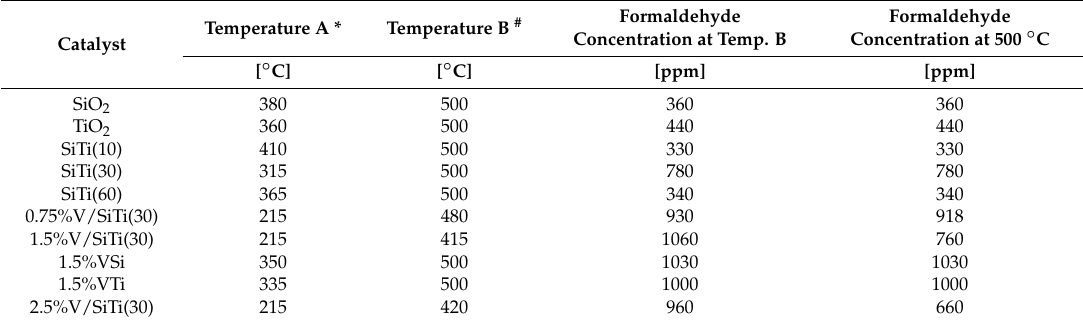
Table 3. Comparison of different catalysts in the reaction (key temperatures and gained maximum formaldehyde concentrations). Feed: 500 ppm methanol and 500 ppm methyl mercaptan, reaction temperature from room temperature to 500 ◦ C.